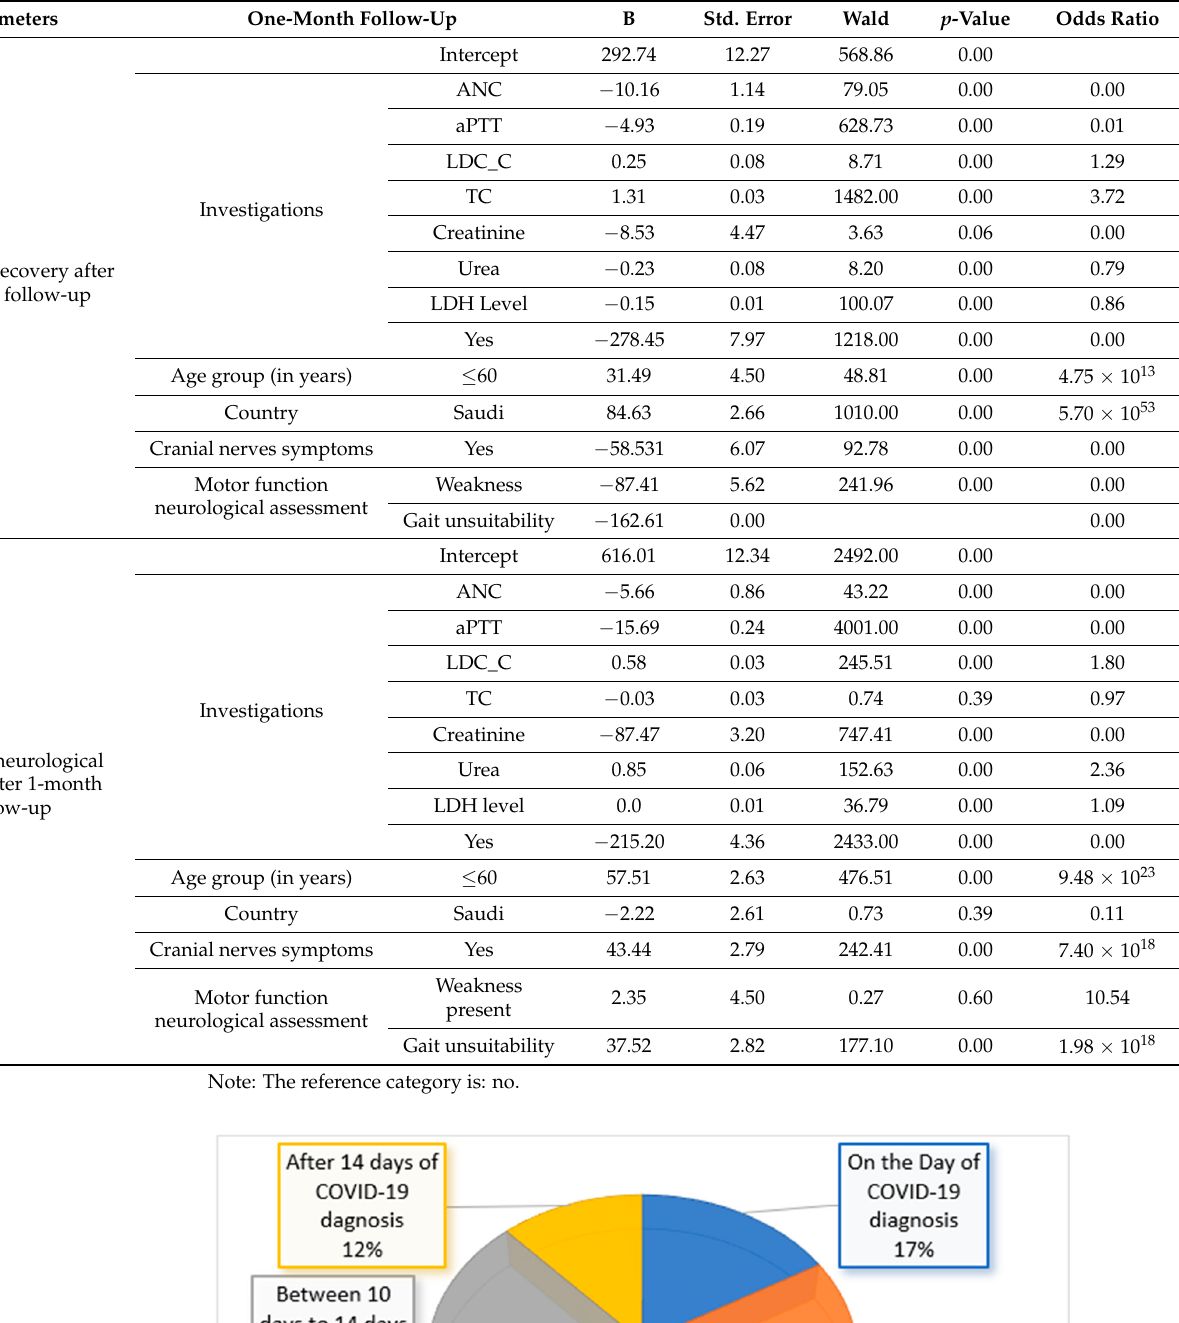
Table 6. Multinomial logistic regression to estimate the association of parameters.